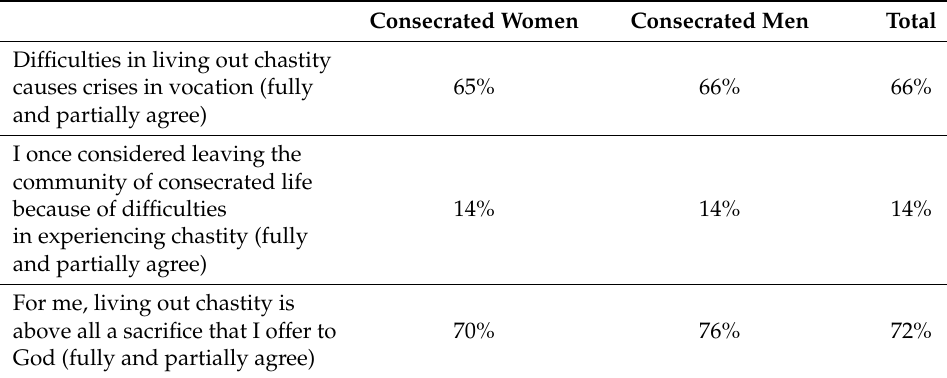
Table 5. Responds for the selected questions. N =